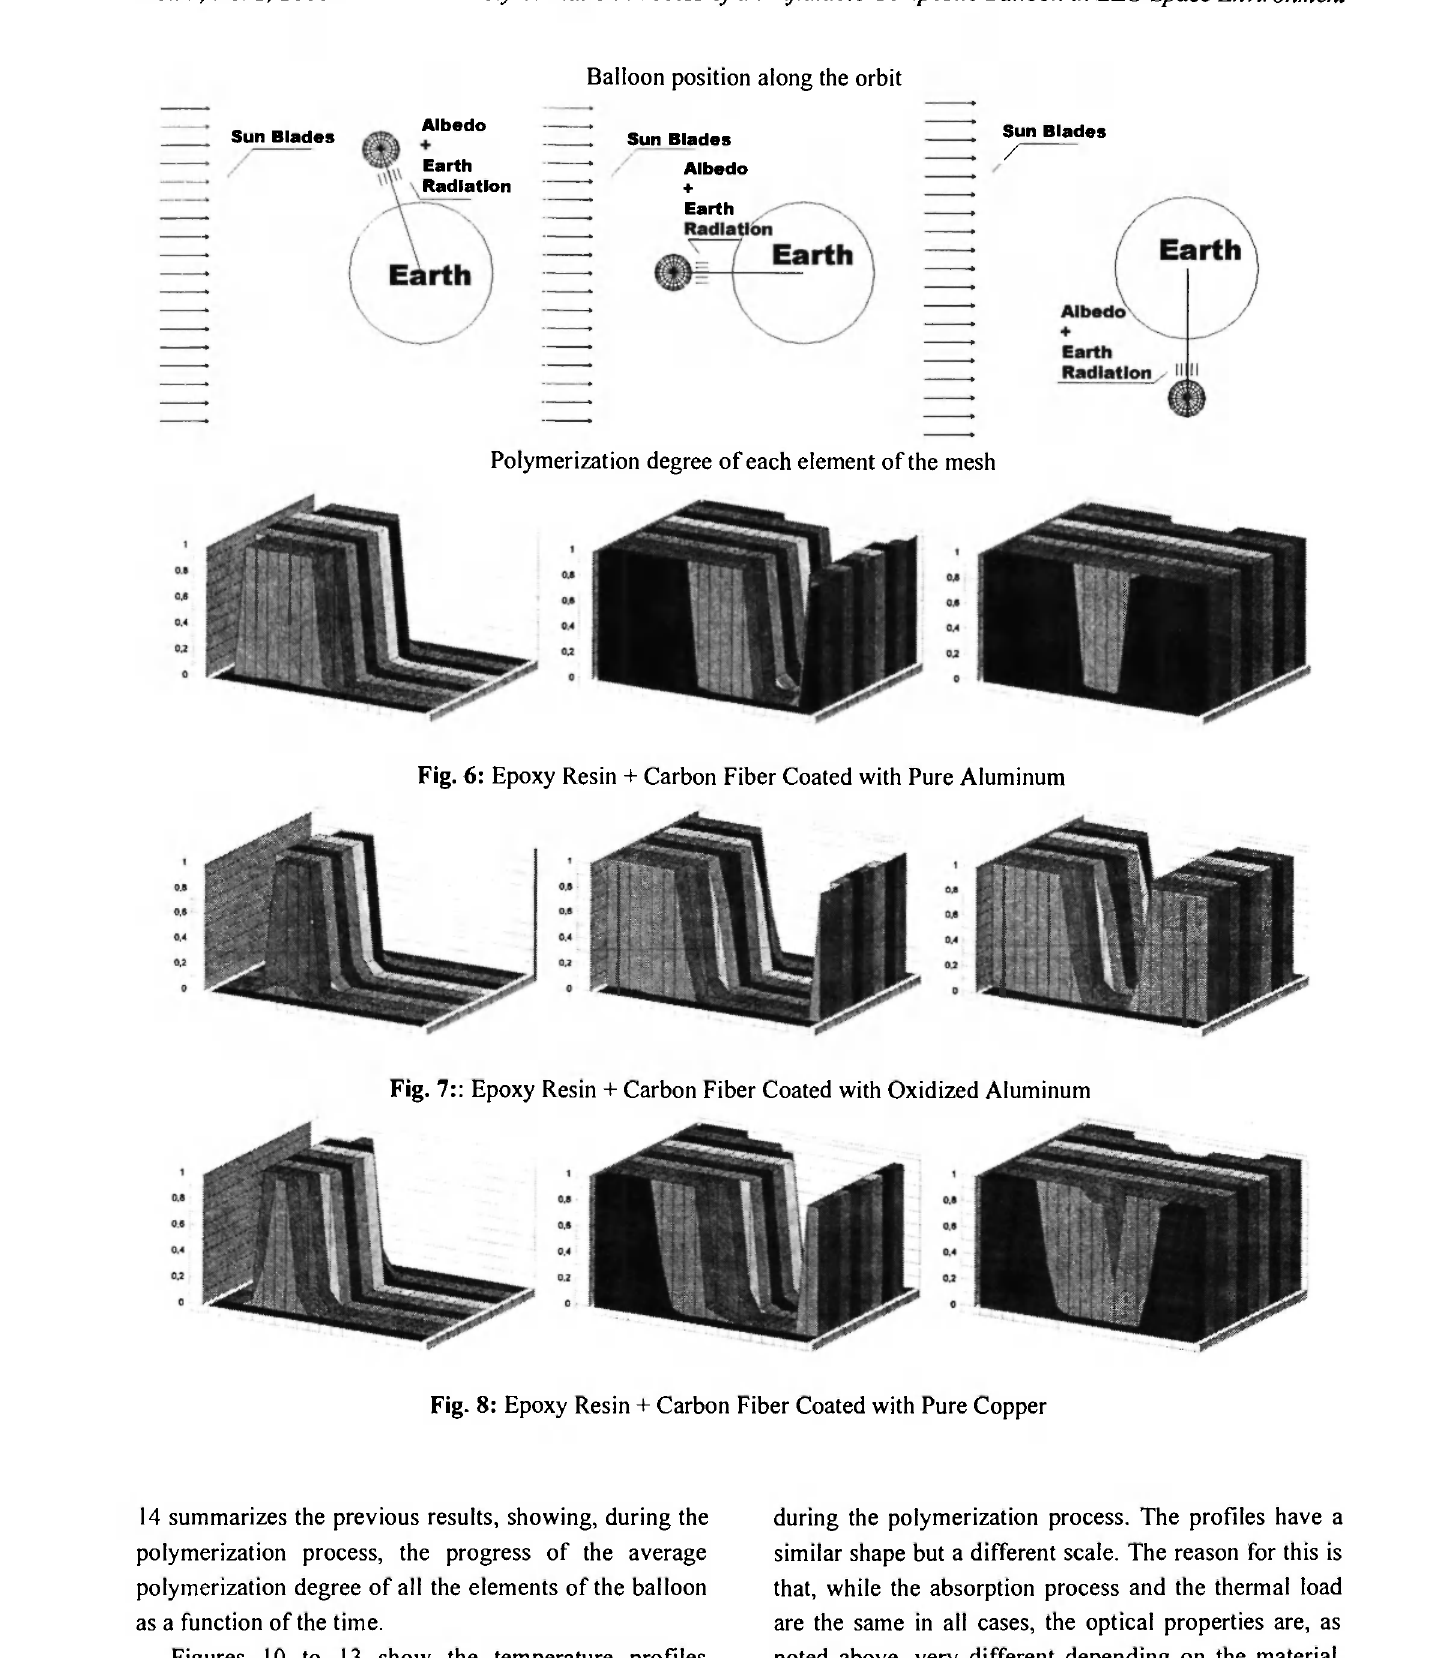
Fig. 8: Epoxy Resin + Carbon Fiber Coated with Pure